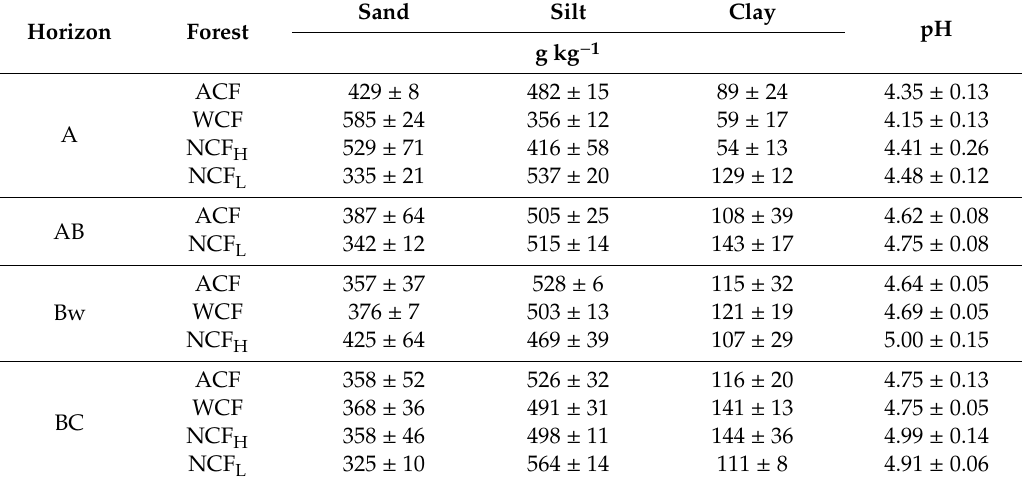
Table 2. Mean ± standard error of sand, silt and clay contents, and pH of the soils under an abandoned chestnut forest (ACF), a chestnut forest for wood production with a tree density of 151 plants ha − 1 (WCF), a chestnut forest for nut production with a tree density of 120 plants ha − 1 (NCF H ) and a chestnut forest for nut production with a tree density of 98 plants ha − 1 (NCF L